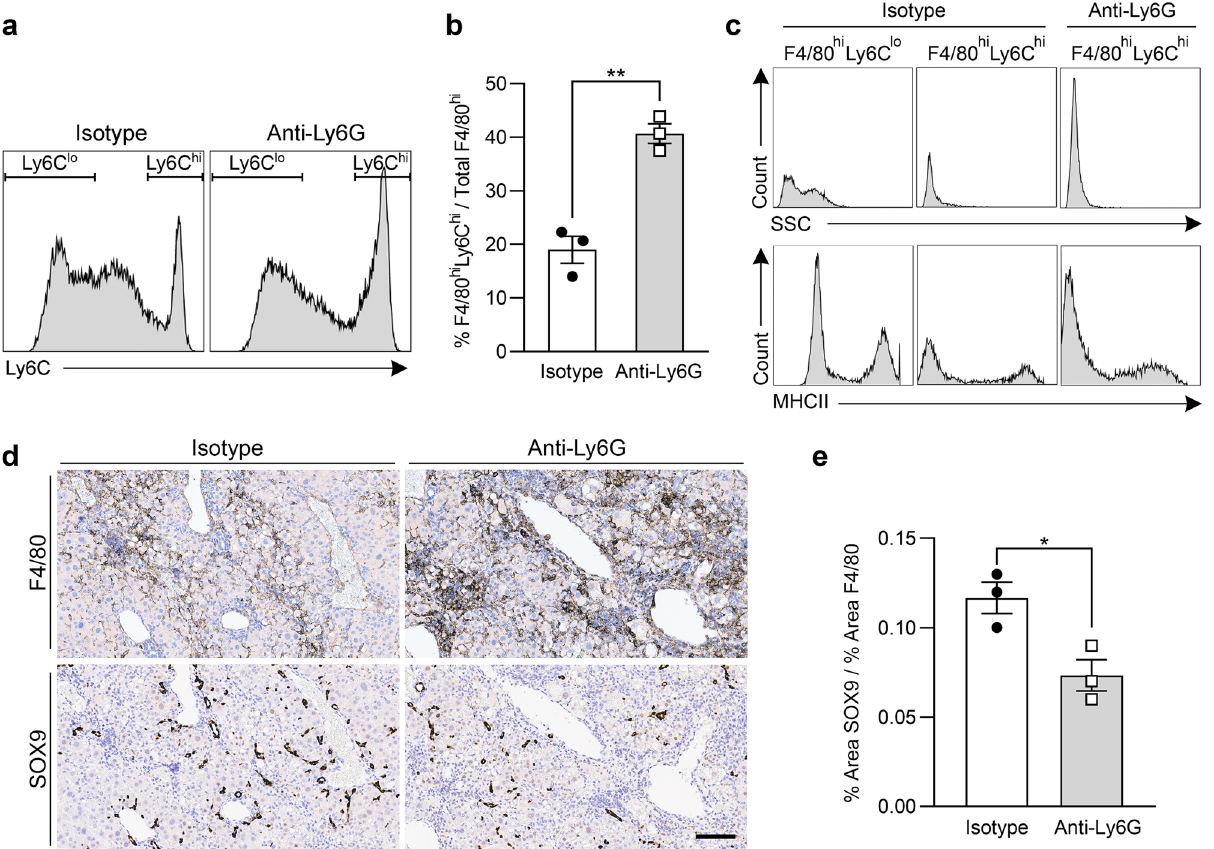
Figure 6. Neutrophil depletion increases the proportion of F4/80 hi Ly6C hi macrophages in IRE-treated liver, and areas of F4/80 + macrophage clusters correlate with lower numbers of SOX9 + liver progenitors. ( a ) Representative flow cytometry histograms showing Ly6C expression in CD11b + F4/80 hi macrophages isolated from